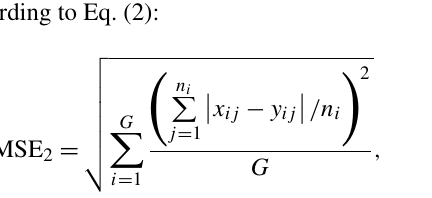
value ( y i ) according to Eq.